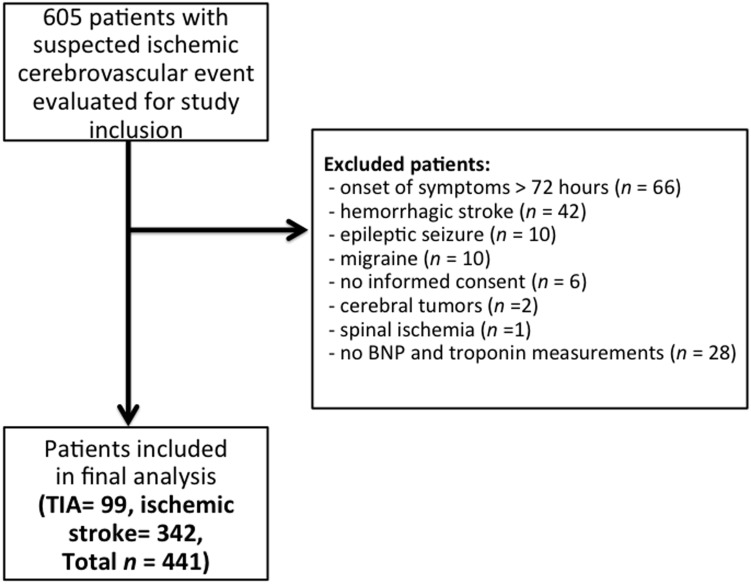
Study flow chart.